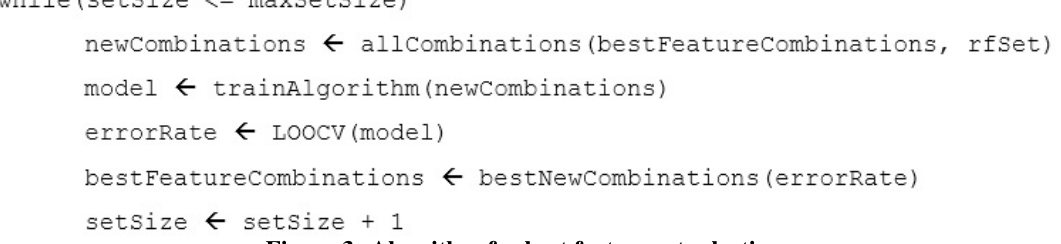
Figure 3: Algorithm for best feature set